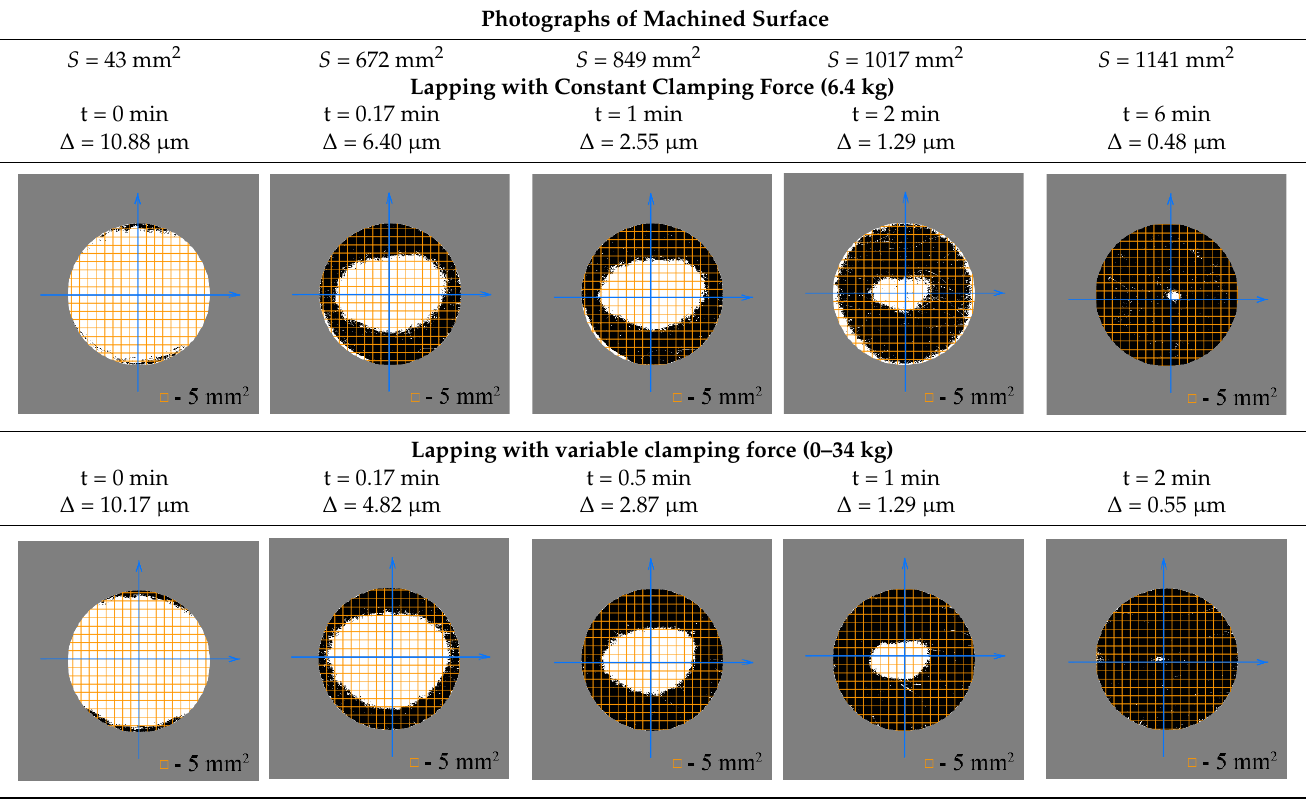
Table 10. Variation in contour area of the machined surface.